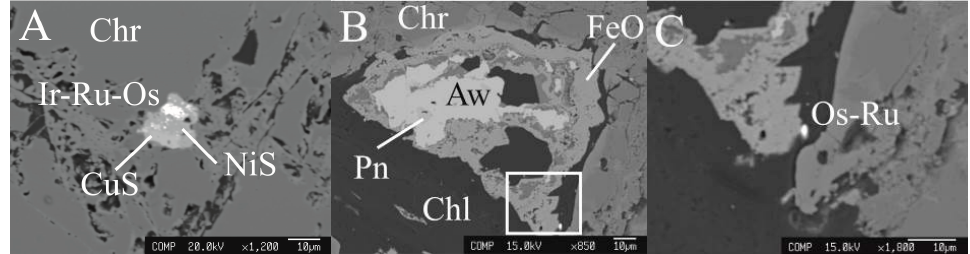
Figure 8. Back-scattered electron (BSE) images of secondary PGM associated with the chromitites from Alapaevsky. ( A ) Irregular alloy of Ir, Ru, Os, Ni-sulfide and Cu-sulfide in contact with ferrian chromite, from the chromitite of Kurmanovskoe; ( B ) complex grain composed pentlandite, awaruite, Fe-oxide or hydroxide in contact with ferrian-chromite and chlorite (Krest); ( C ) enlargement of ( B ) showing an alloy composed of Os and Ru. Abbreviations: Ir–Ru–Os = iridium alloy; Aw = awaruite; Pn = pentlandite; Fe–O = Fe-oxide or hydroxide; Chl = chlorite; Os–Ru = osmium alloy; other abbreviations = see Figure 7.